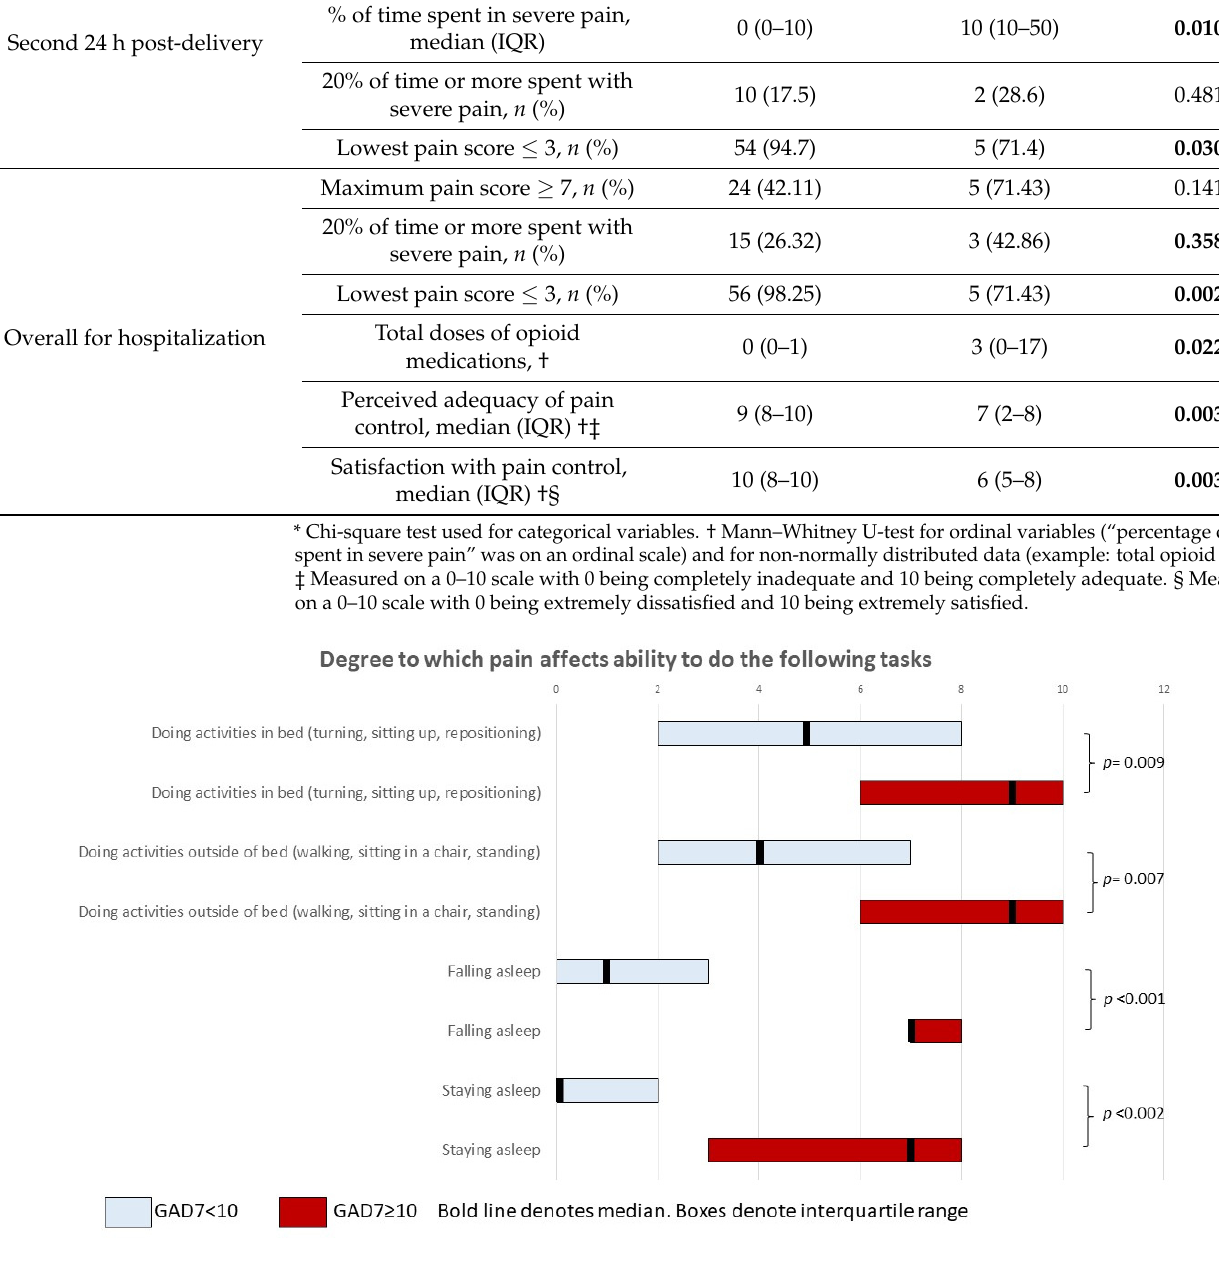
Figure 2. Responses to the question: “Pain can affect how we do daily tasks. Please choose the option that best describes how much your pain after giving birth interfered with or prevented you for doing the following things while in the hospital. 0 = did not interfere at all, 10 = completely interfered”. Median and interquartile ranges of responses, Mann–Whitney U-test performed. GAD-7 results < 10 are shown in light blue, GAD-7 results ≥ 10 are shown in red. Bold line denotes the median and boxes denote the interquartile range.